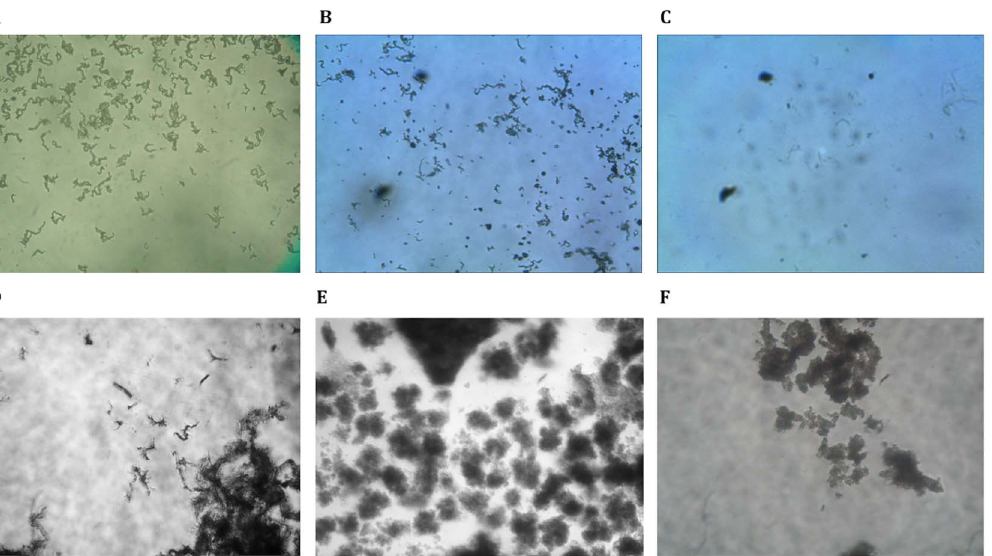
Figure 2. Digital photos of MODS cultures . Corresponding to: (A, B) Mycobacterium tuberculosis ; (C) Objects from sediment and detritus of a mycobacterium negative sample; (D) Mycobacterium kansasii ; (E) Mycobacterium avium ; (F) Mycobacterium chelonae.